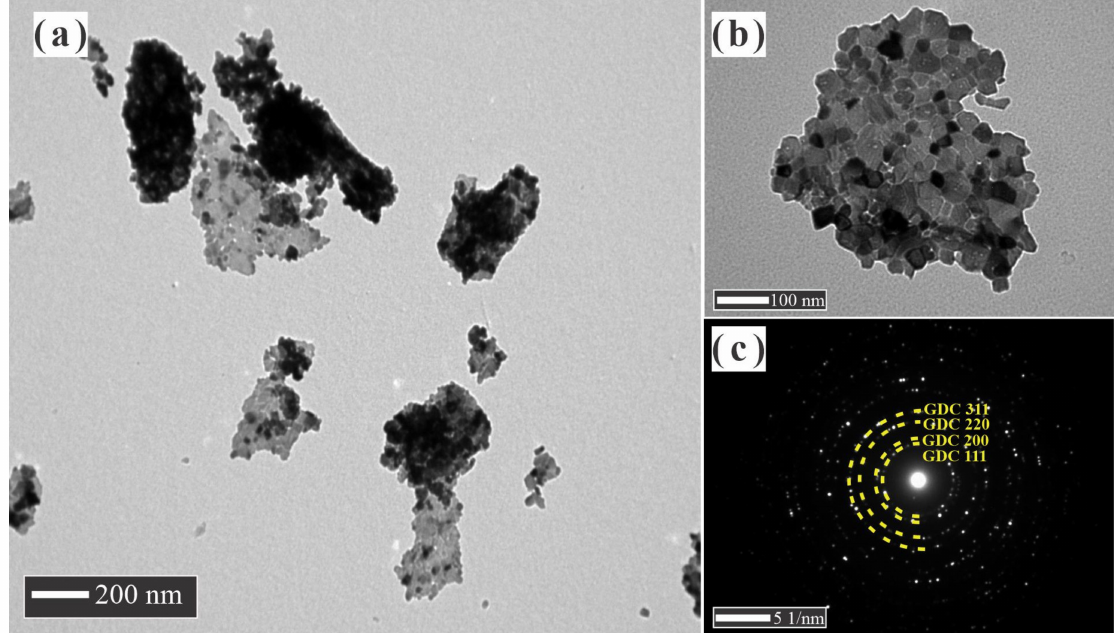
Figure 3. ( a , b ) TEM images and ( c ) SAED pattern of GDC powders.